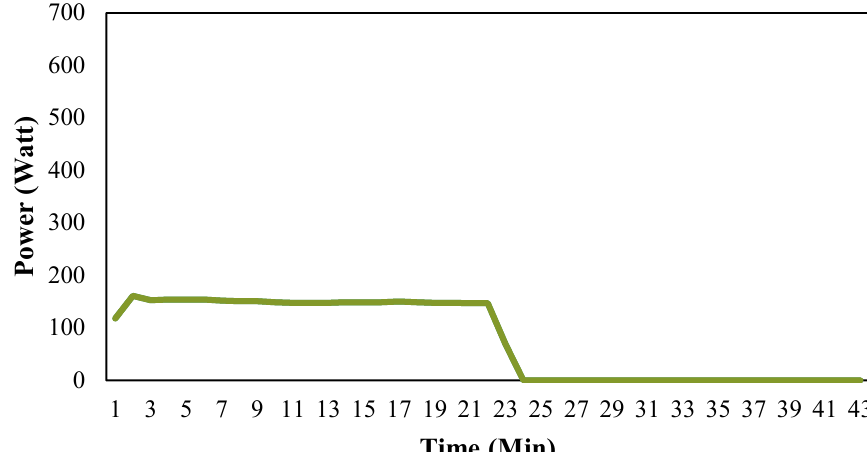
Figure 1. Typical household refrigerator operation cycle for 24 h